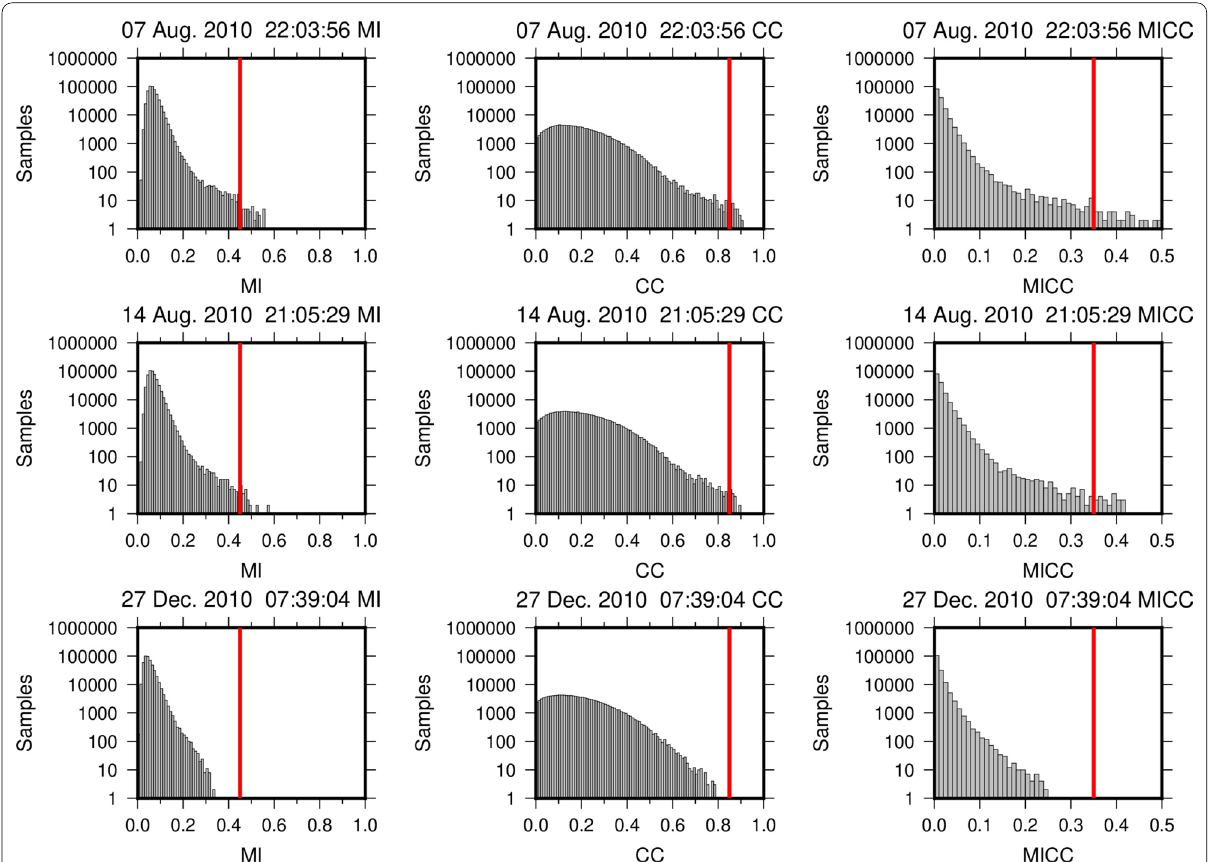
Fig. 9 Histograms of the local maximum values of three indices (MI, CC, and MICC) extracted from each time series. Three representative templates that detect many DLF earthquakes are shown out of the original 200 templates. Vertical axes correspond to the number of samples in each bin (width, 0.01). The time at the top of each panel is the time of occurrence of the template event (JST). Applied data are for one day, 21 December 2010. Red lines show the threshold value for each